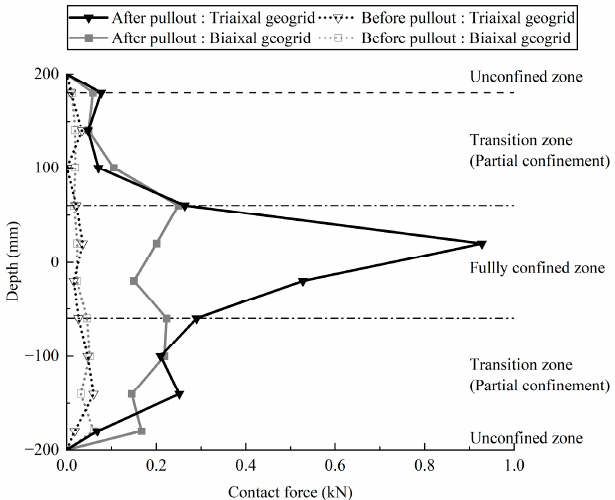
Figure 12. Contact force applied on the front wall before and during the pullout test simulation .